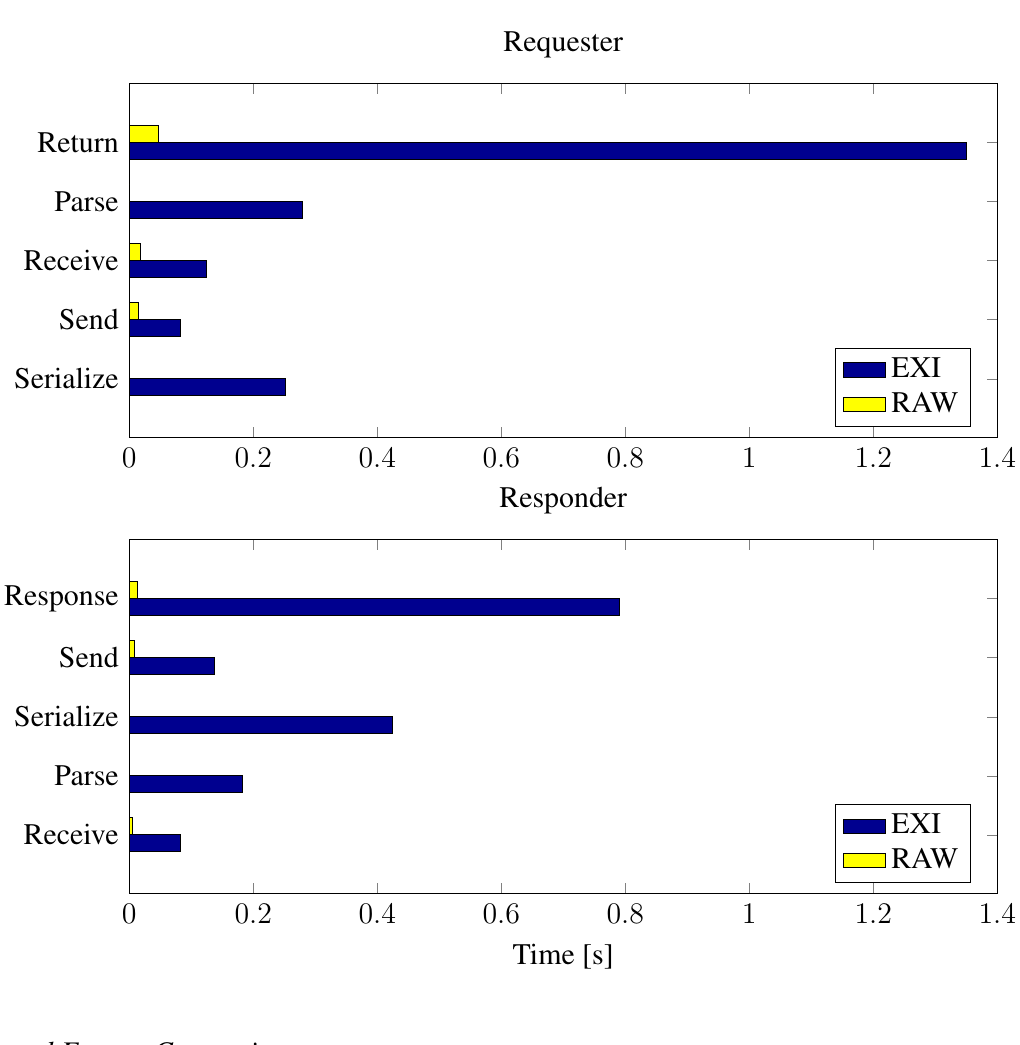
Figure 10. Visual presentation of Table 2, average processing times in communication